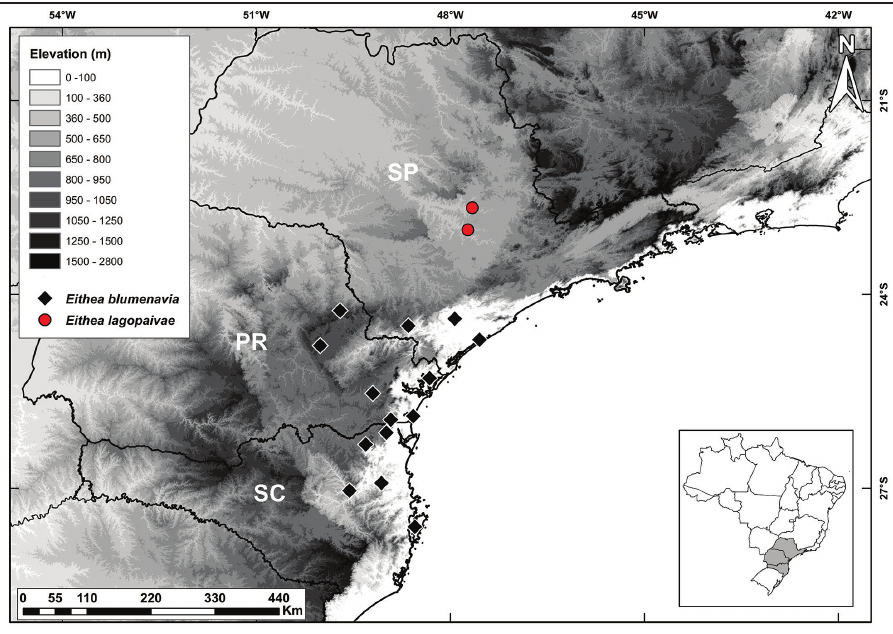
Figure 4. Distribution map showing collections of Eithea lagopaivae (red circles) and E. blumenavia (black diamonds). PR = Paraná. SC = Santa Catarina. SP = São